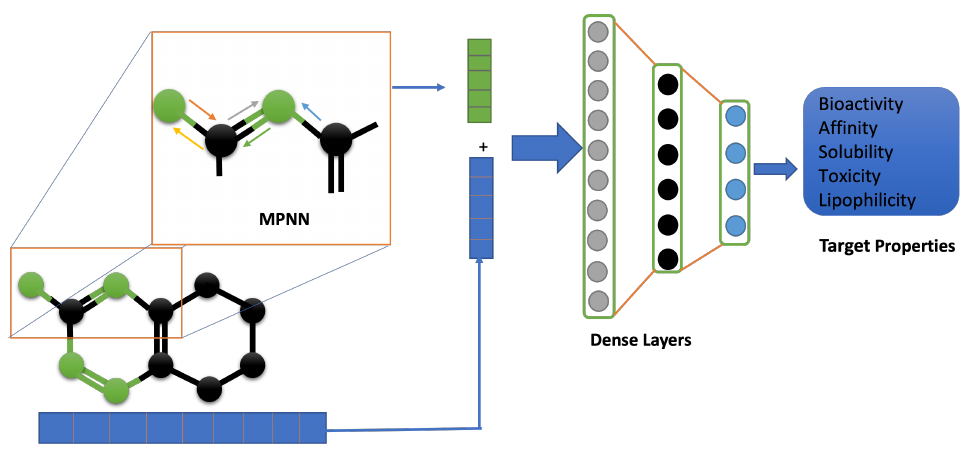
Figure 4. Physics-informed ML framework for predictive modeling. It takes into account the properties obtained from quantum mechanics-based simulation or from experimental data to ultimately generate features in addition to the standard process used in benchmark models (e.g., message passing neural network